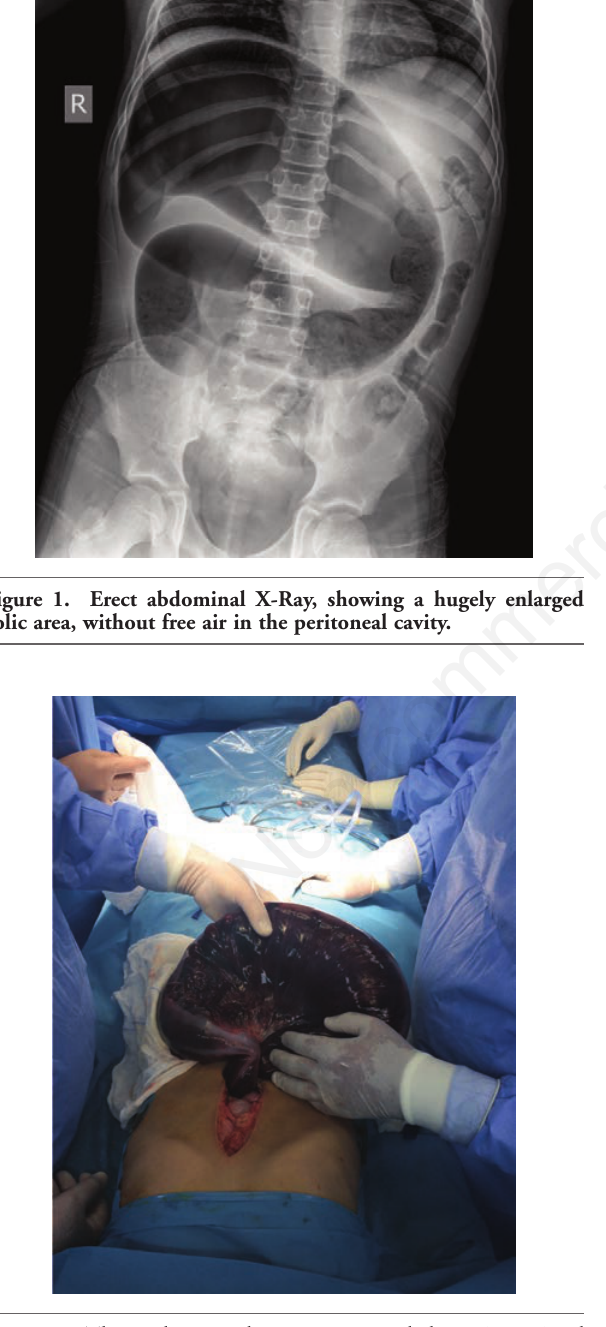
Figure 3. The exploratory laparotomy revealed a twice twisted sigmoid colon in a clockwise direction, with no macroscopic signs of perforation.